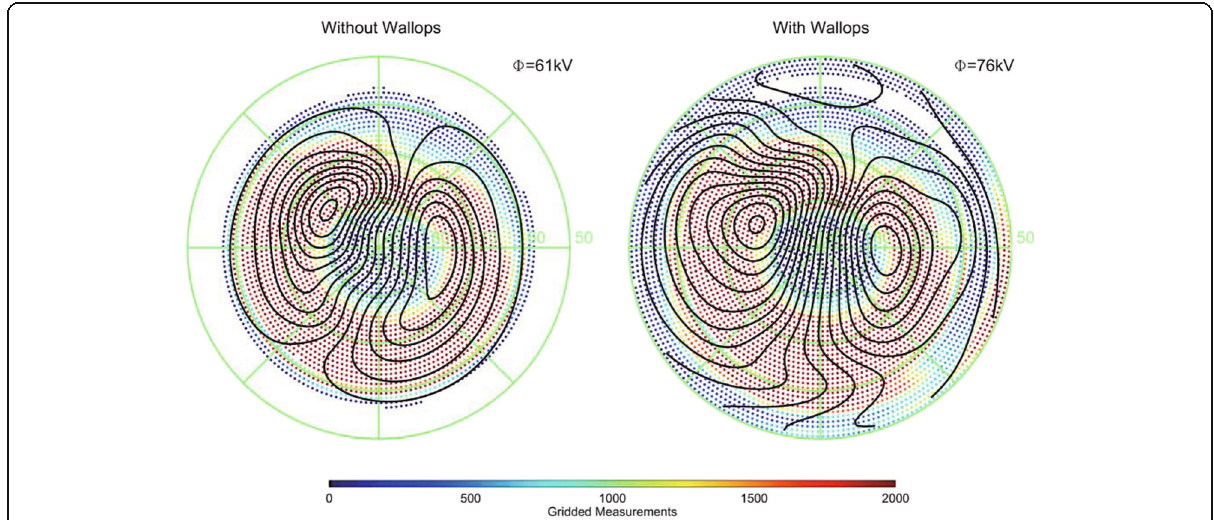
Fig. 9 Average patterns of Northern Hemisphere ionospheric convection calculated from SuperDARN data collected during periods of increased geomagnetic activity ( Kp ≥ 3) between June 2005 and April 2006. Contours of the global solution of electrostatic potential are shown as black lines spaced every 4 kV. Adapted from Fig. 12 of Baker et al.